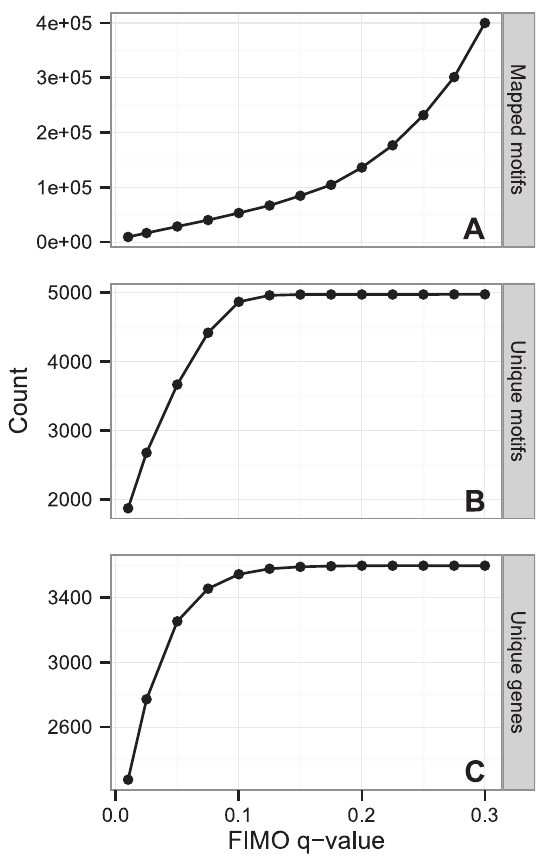
Figure 3. Central motifs mapped to Synechocystis promoters. The plots show the total number of times the central motifs were mapped to promoters (A), the number of unique motifs that were mapped (B) and the number of unique genes the motifs were mapped to (C) for different FIMO q -value